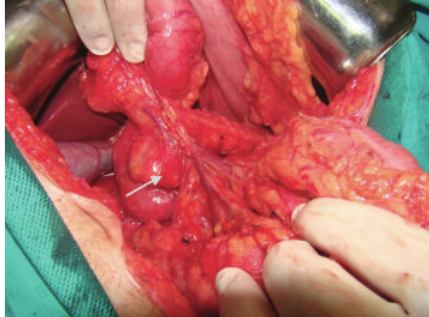
Figure 2: Intraoperatively on palpation, 1cm nodular lesion in the head of the